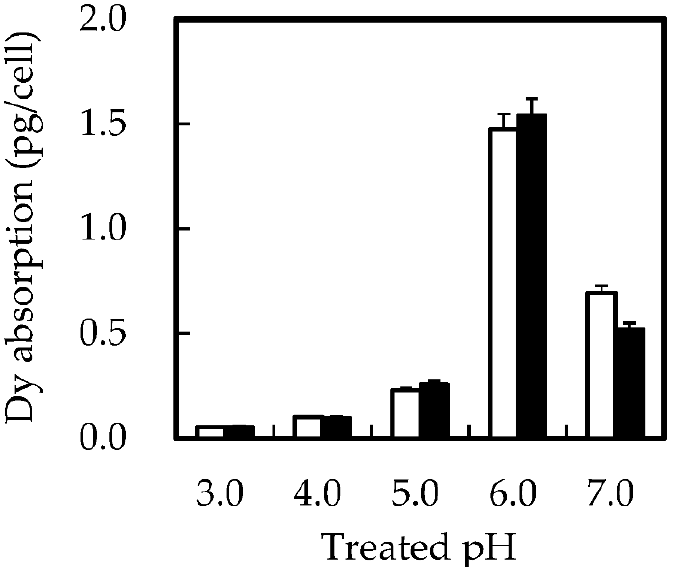
Figure 3. Effect of treated pH on Dy absorption in Alt-OF2 and Alt-OF5. Yeast (Alt-OF2 and Alt-OF5) cells were treated with 10 mM sodium acetate buffer at pH 3.0–7.0 containing 0.1 g/L of Dy acetate for 2 h. White and black columns represent Alt-OF2 and Alt-OF5, respectively.